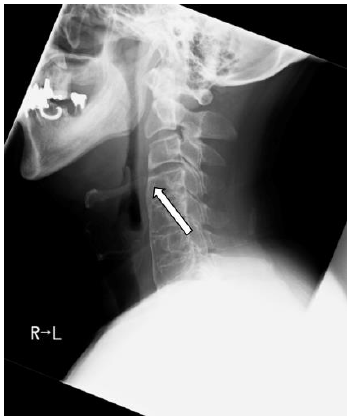
Figure 5. Postoperatively, the ossification was reduced by resection (arrow).